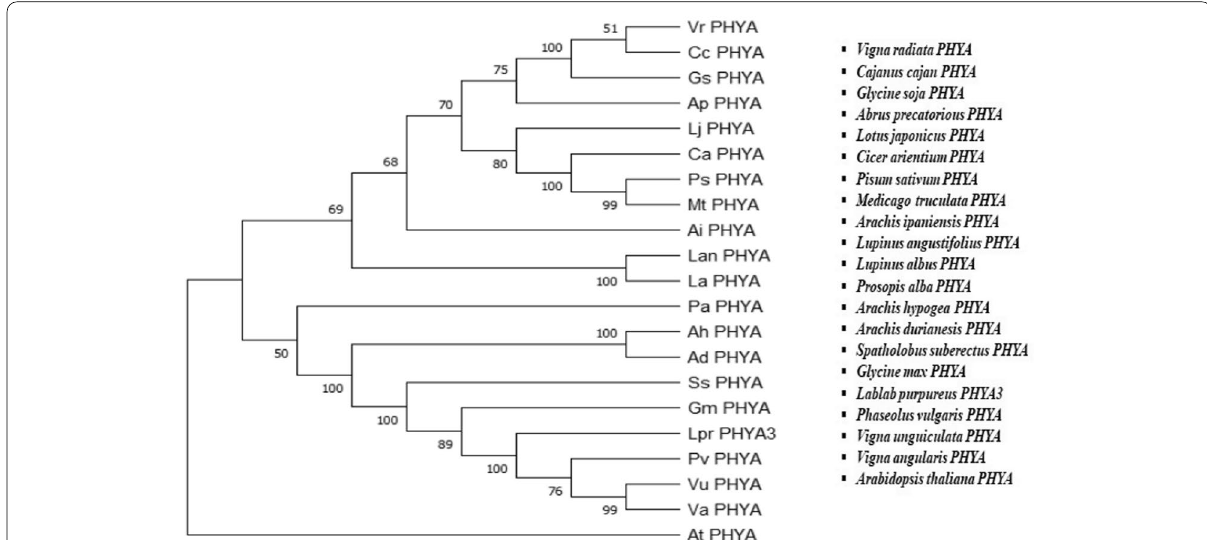
Fig. 2 Phylogenetic tree of amino acid sequences of phytochrome A by Maximum Likelihood algorithm showing evolutionary lineage using MEGA X software. The bootstrap consensus tree is inferred from 1000 replicates; with the confidence values shown next to the branches, Arabidopsis thaliana is an